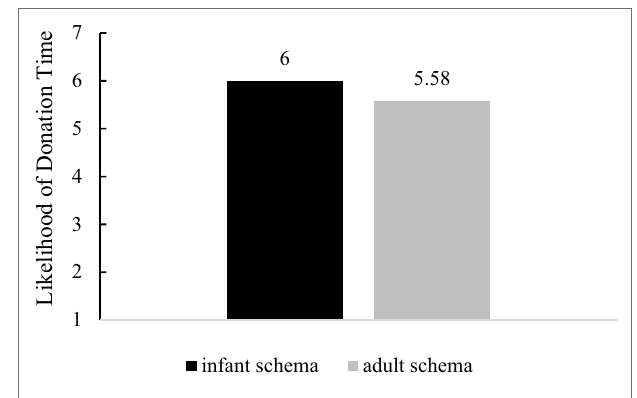
FIGURE 1 | Influence of infant schema cues on donation